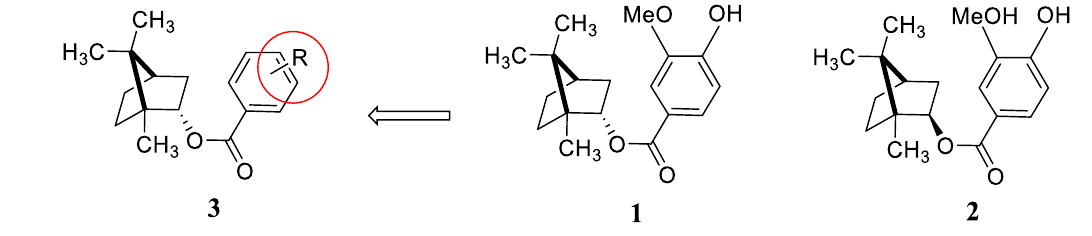
Figure 1. Design strategy for novel tertiary alcohols.